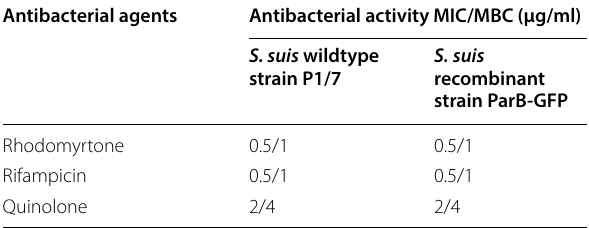
Table 1. MIC and MBC values of rhodomyrtone ranged from 0.5 and 1 µg/ml, which were equivalent to those of rifampicin, while MIC and MBC of quinolone were 2 and 4 µg/ml, respectively. The antibacterial efficacy of rhodo- myrtone was further determined by time-kill assay. The bactericidal activity of rhodomyrtone was concentration and time dependence. In ParB-GFP S. suis , three log-fold decrease in cell numbers was evident within 4 h (Fig. 3b), compared with 3 h in the wildtype parent strain (Fig. 3a), following the treatment with 1 µg/ml